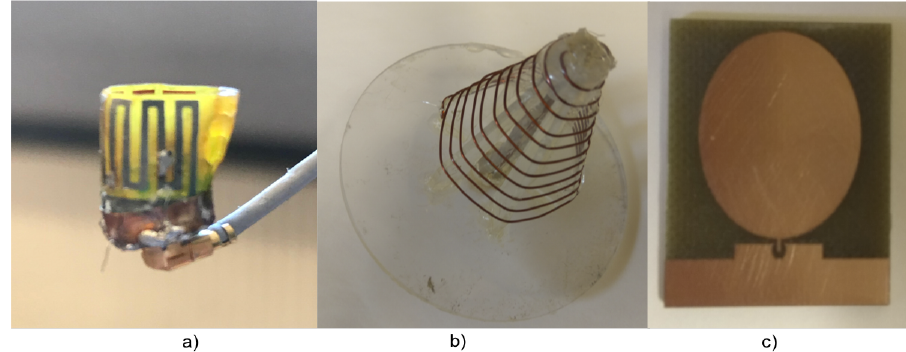
Figure 5. ISM band antennas ( a ) Transmitter ( b ) Eve antenna ( c ) legitimate Receiver.